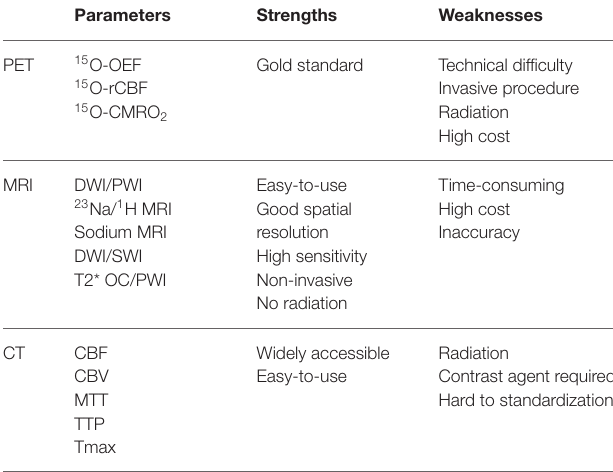
TABLE 2 | Comparison of strengths and weaknesses of different imaging modalities for penumbra identification. Parameters